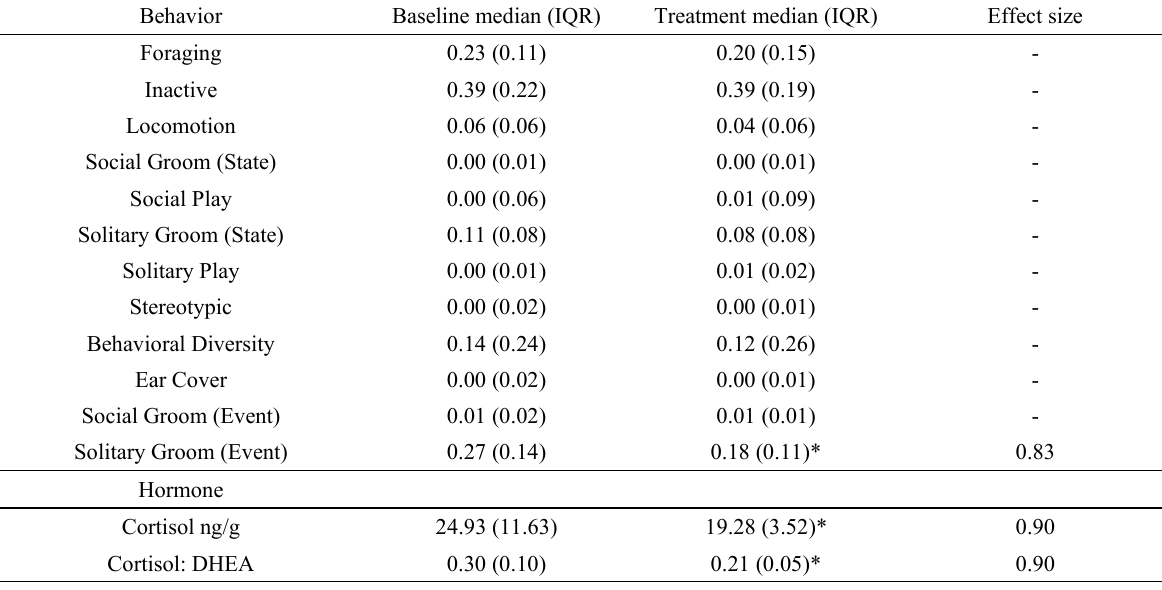
Results for Behavioral and Physiological Data Comparing Baseline, the Restricted Viewing Treatment, and Effect Size Behavior Baseline median